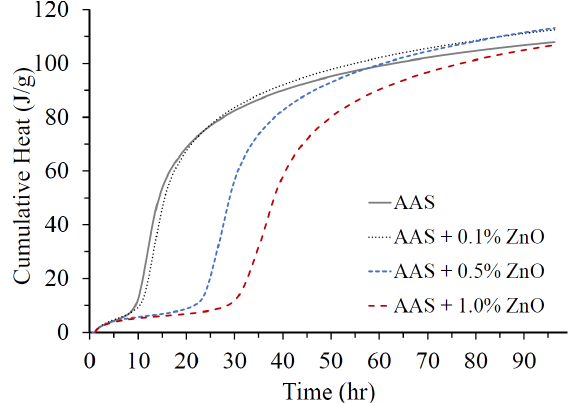
Figure 1. Isothermal conduction calorimetry cumulative heat curves of neat alkali ‐ activated slag (AAS) synthesized using a sodium silicate activator (4 wt. % Na 2 O relative to slag, SiO 2 /Na 2 O molar ratio of 1.0 for activator and water/slag wt. ratio of 0.44), and AAS with 0.1%, 0.5% and 1.0% nano ‐ ZnO (by wt. relative to amount of slag). The nano ‐ ZnO was added to the activator immediately prior to sample synthesis.